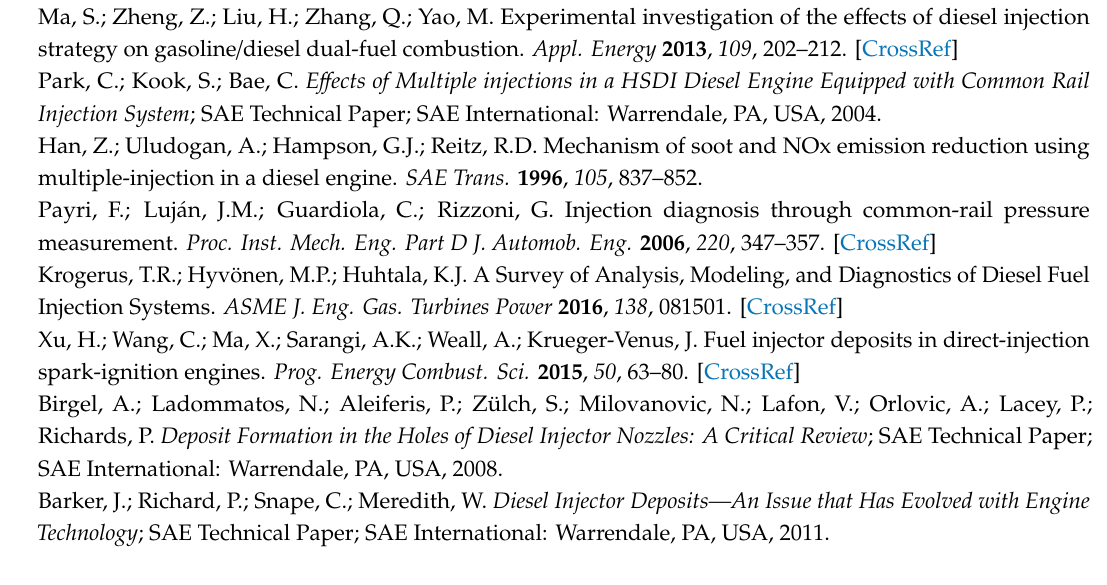
Figure A7. Illustration of a final region of interest created for further analysis.